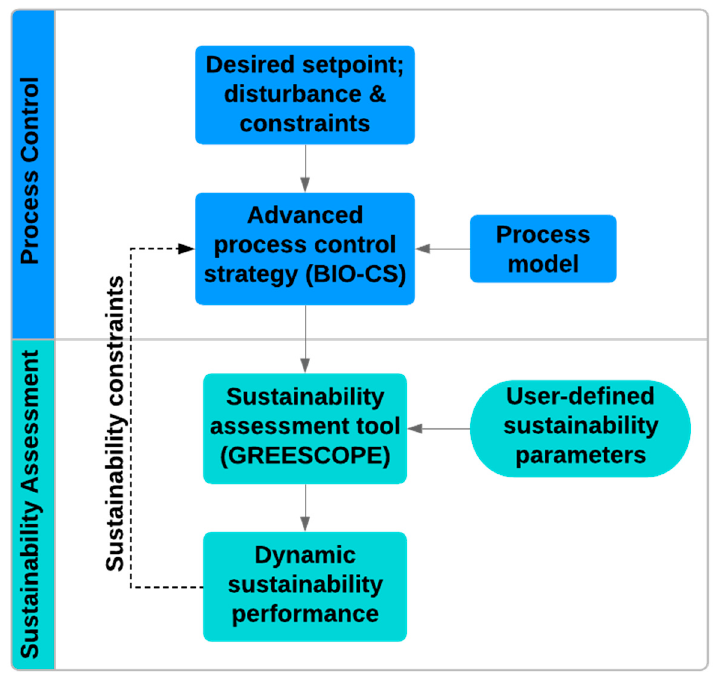
Figure 2. Proposed framework for novel sustainable process control.